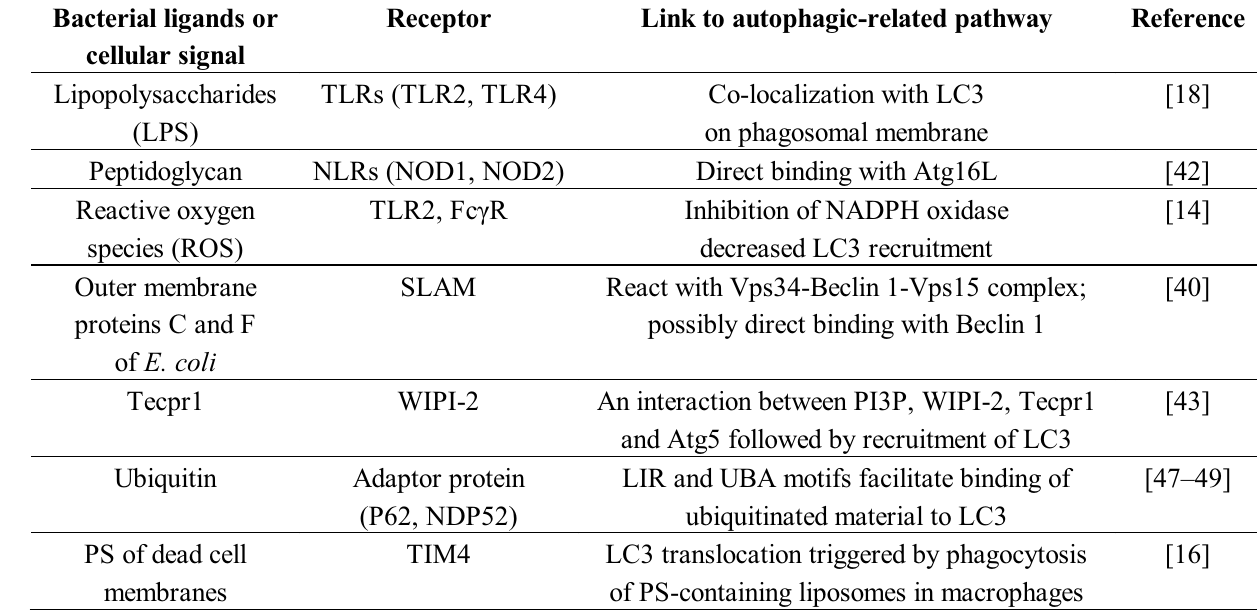
Table 1. Possible factors that trigger LC3-associated phagocytosis